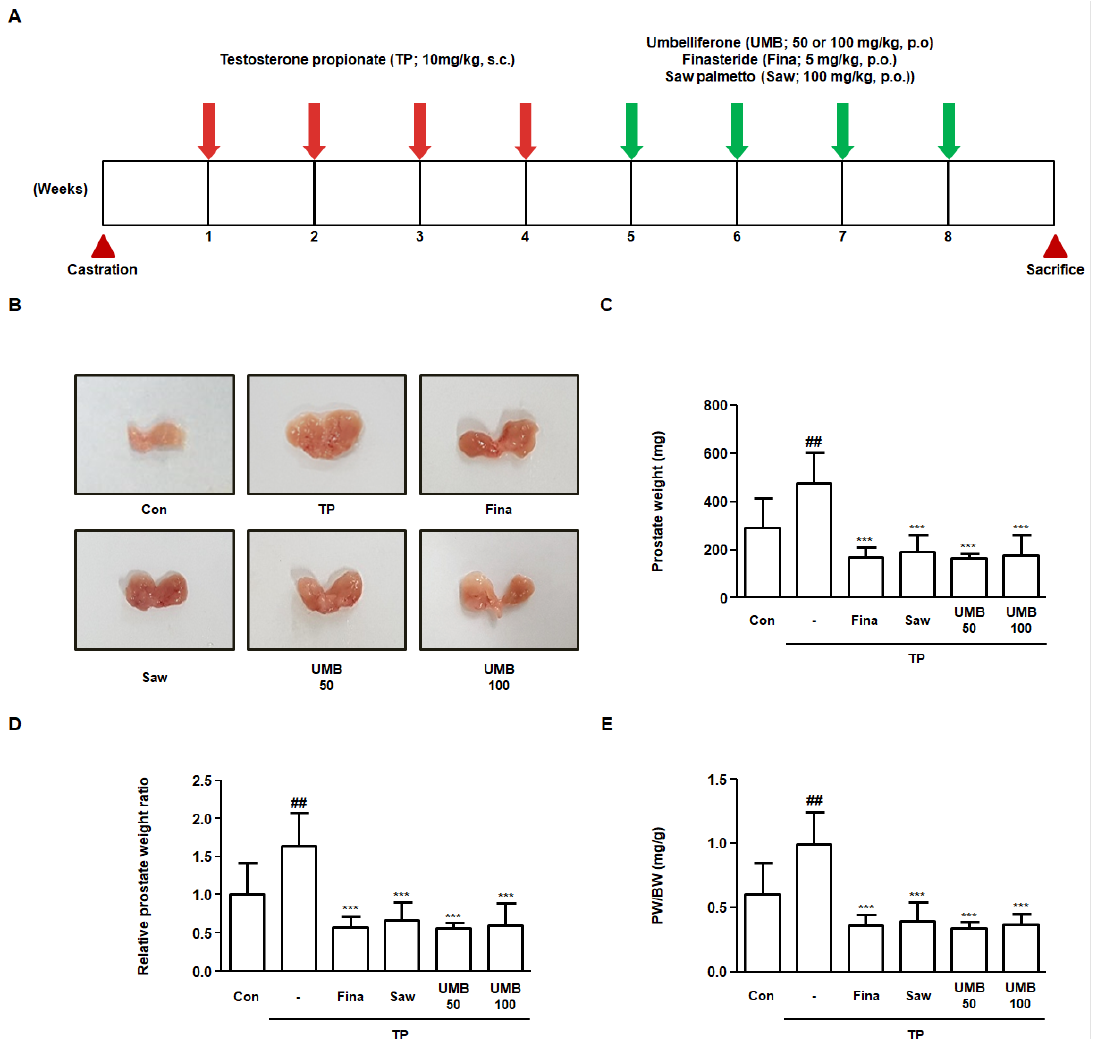
Figure 5. Effect of UMB on prostate enlargement in TP-induced rats. ( A ) Schematic overview of the experimental design of the in vivo study. ( B ) Visual comparison of the prostates of six experimental groups. ( C – E ) Comparative analysis of prostate weight in each group. ( C ) Prostate weight, ( D ) relative prostate weight ratio, and ( E ) prostate weight to body weight (PW/BW) ratio were measured. Relative prostate weight ratio was calculated by dividing the individual prostate weights of the experimental group by the mean prostate weight of the Con. The PW/BW ratio was calculated by dividing the prostate weight (mg) by the mean body weight (g). The data represent as mean ± S.D. of five rats per group. ## p < 0.01 vs. Con group; *** p < 0.001 vs. TP group.